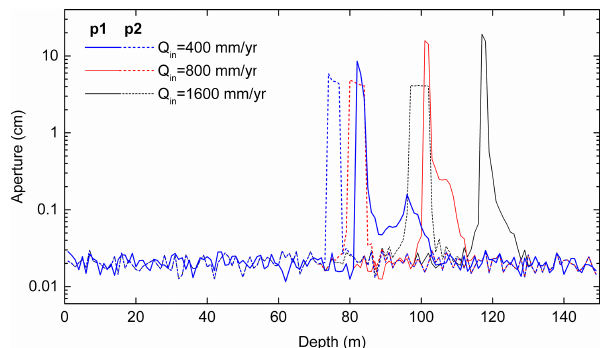
Figure 7. Vertical profiles of horizontal fracture aperture widths along positions p1 and p2 shown in Fig. 6 after 40000 years of